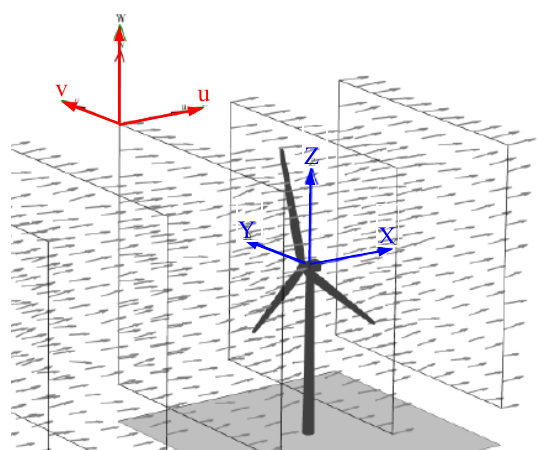
Figure 14. Example of wind field simulation in TurbSim [24].